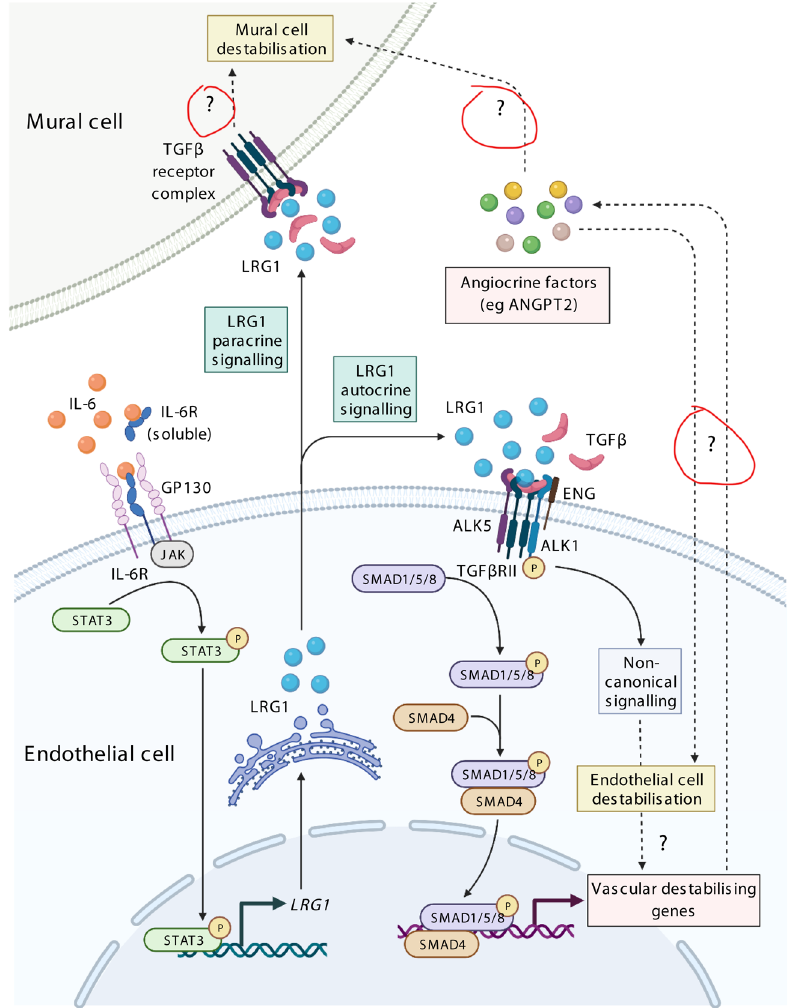
Figure 6. IL-6-dependent induction of LRG1 and proposed downstream angiopathic effector mechanisms. IL-6 induces LRG1 in endothelial cells, but not mural cells. LRG1 may then act in an autocrine loop on endothelial cells through the TGFβ receptor complex to activate canonical and non-canonical signalling that will modify endothelial cell function and induce vascular destabilising genes. In turn, the LRG1-mediated induction of angiocrine factors may result in indirect angiopathic effects on endothelial cells and mural cells. Alternatively, LRG1 may signal in a paracrine fashion directly on mural cells to drive destabilisation. Dashed lines with question marks represent speculative pathways. Created with